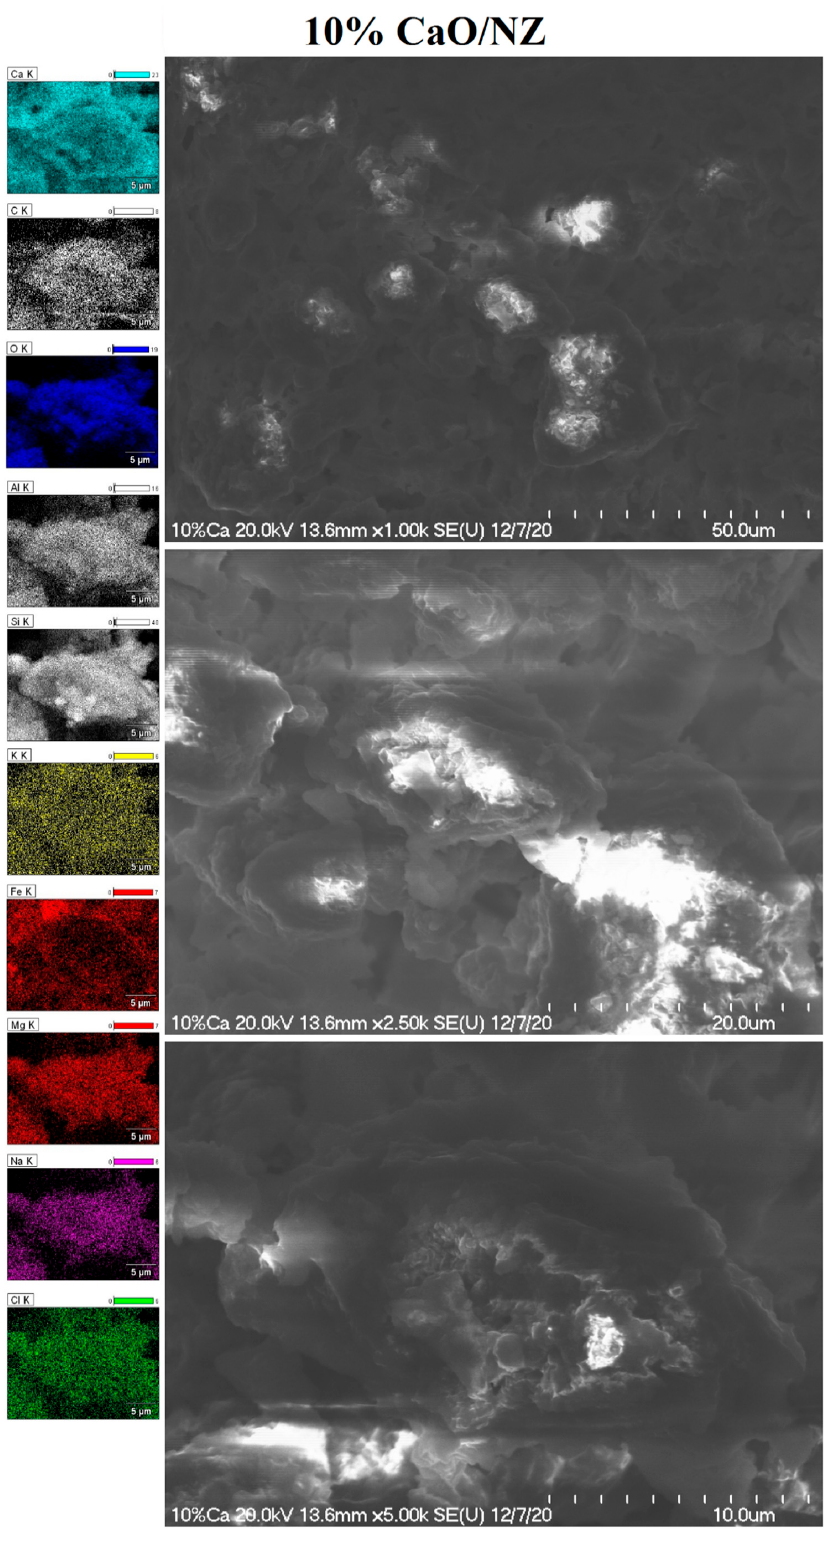
Figure 3. SEM-EDS images of the calcined metal oxide 10% CaO/NZ catalyst in an air atmosphere at 400 °C for 4 h.